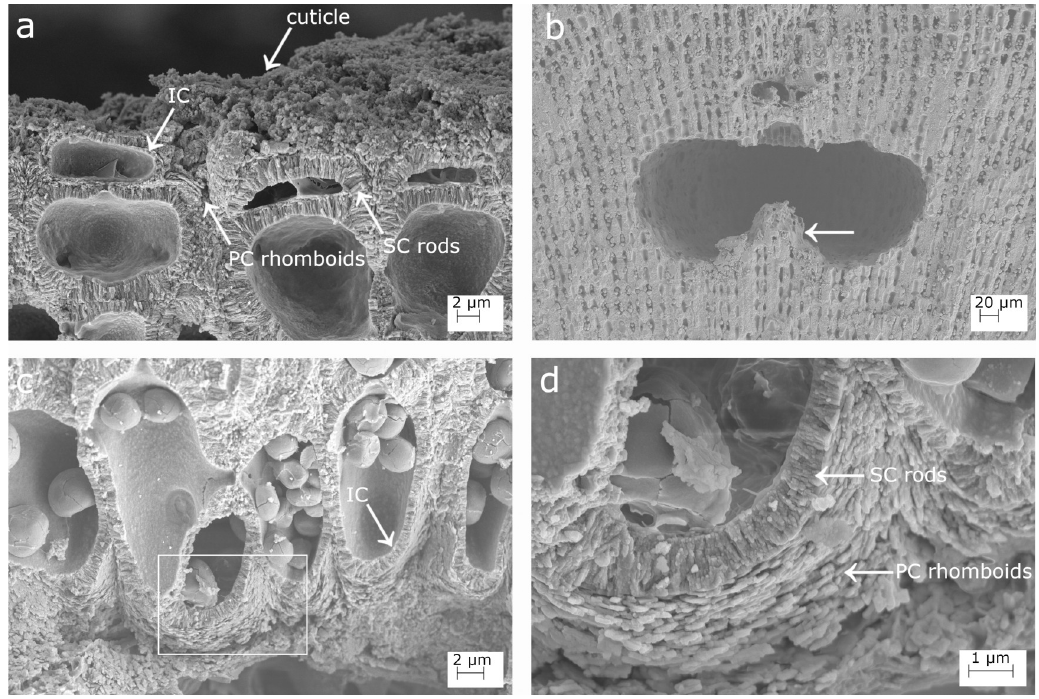
Fig 5. SEM images showing longitudinal sections in Lithophyllum cf. racemus DB865. (a) Epithallial calcified cells covered by a thick cuticle, and bordered by a primary calcification (PC), a secondary calcification (SC), and an innermost calcified layer (IC); (b) a conceptacle with a well-defined calcified columella (white arrow); (c) secondary hypothallial cells in the proximity of a pore canal and the innermost granular IC; (d) magnification of the inset in (c) showing the SC rhomboidal crystallites, and the PC